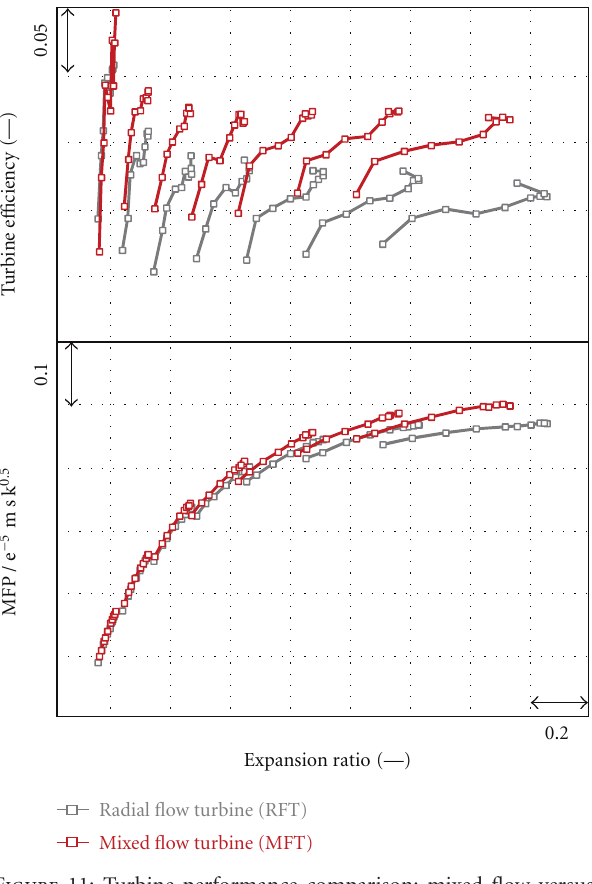
Figure 11: Turbine performance comparison: mixed flow versus radial flow turbine.